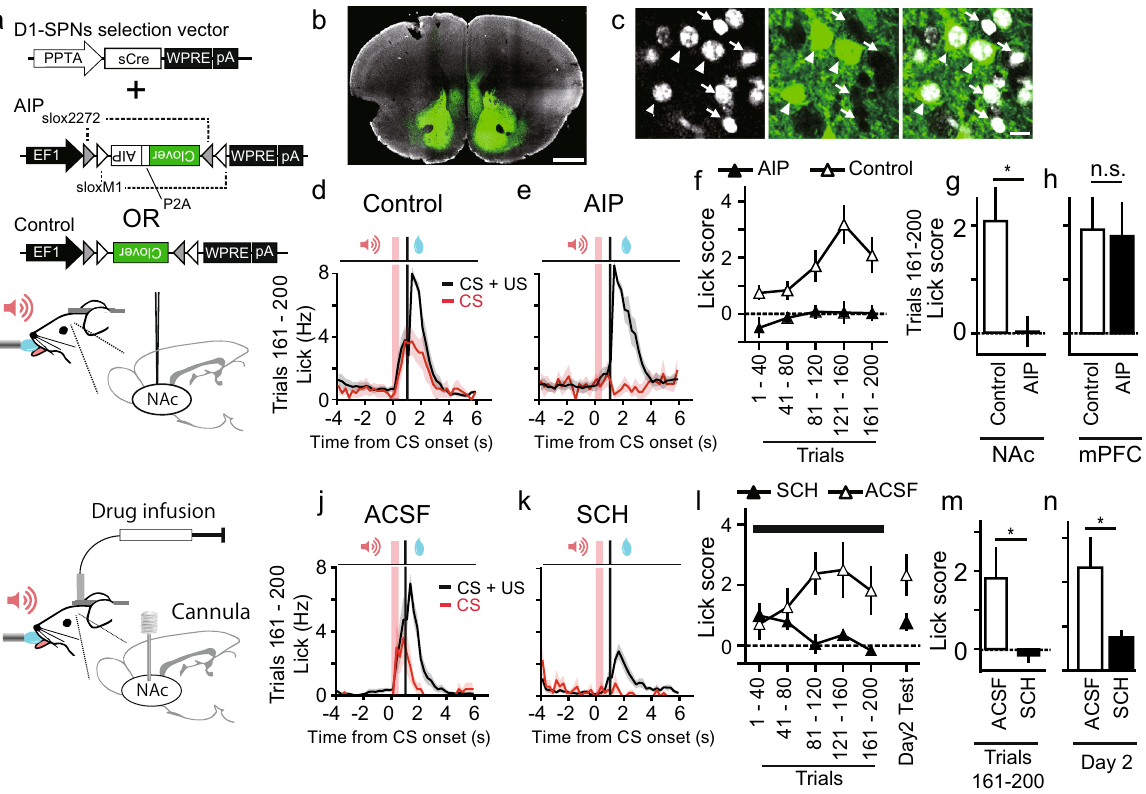
Figure 3. The effect of a D1 receptor blocker and CaMKII inhibitory peptide (AIP) in the NAc on conditioning. ( a ) Viral constructs and schematics of injection. ( b , c ) Confocal images of clover fluorescence (green) and DAPI (white) from a coronal slice, including the NAc. Slices were counter-stained with DAPI, and 35.8% (72/201) of cells were positive for AIP. Arrowheads indicate AIP-positive cells, and arrows indicate negative cells. Scale bars indicate 1 mm ( b ) and 20 μm ( c ). ( d , e ) Averaged PSTHs of the licking responses in CS + US (black) and CS (red) conditionings from mice injected with control ( d , n = 7 mice) or AIP ( e , n = 6 mice). ( f ) The peak lick scores are plotted against time for the conditions indicated. ( g , h ) Average lick scores from eight trials during trials 161–200 from mice with injections in the NAc or injections in the mPFC (this figure, Supplementary Fig. S2 online) were plotted for each condition. * P < 0.05, two-sided Mann–Whitney U test. ( i ) A schematic diagram for drug infusion into the NAc. ( j , k ) Averaged PSTHs of the licking responses in trials 161–200 without ( j , ACSF, n = 5 mice) or with ( k , SCH23390, n = 5 mice) the injection of a D1 blocker during conditioning. ( l ) The lick scores were plotted against time for the two conditions indicated. Drug infusion was started 30 min before the behavioral experiments and was continued during conditioning as indicated by the black horizontal bar. ( m,n ) The effect of a dopamine D1 receptor blocker, SCH23390, on conditioning. Averaged lick scores of CS-only trials during trials 161–200 ( m ) or day 2 ( n ) were plotted. * P < 0.05, two-sided Mann–Whitney U test, n = 5 mice for SCH23390, n = 5 mice for